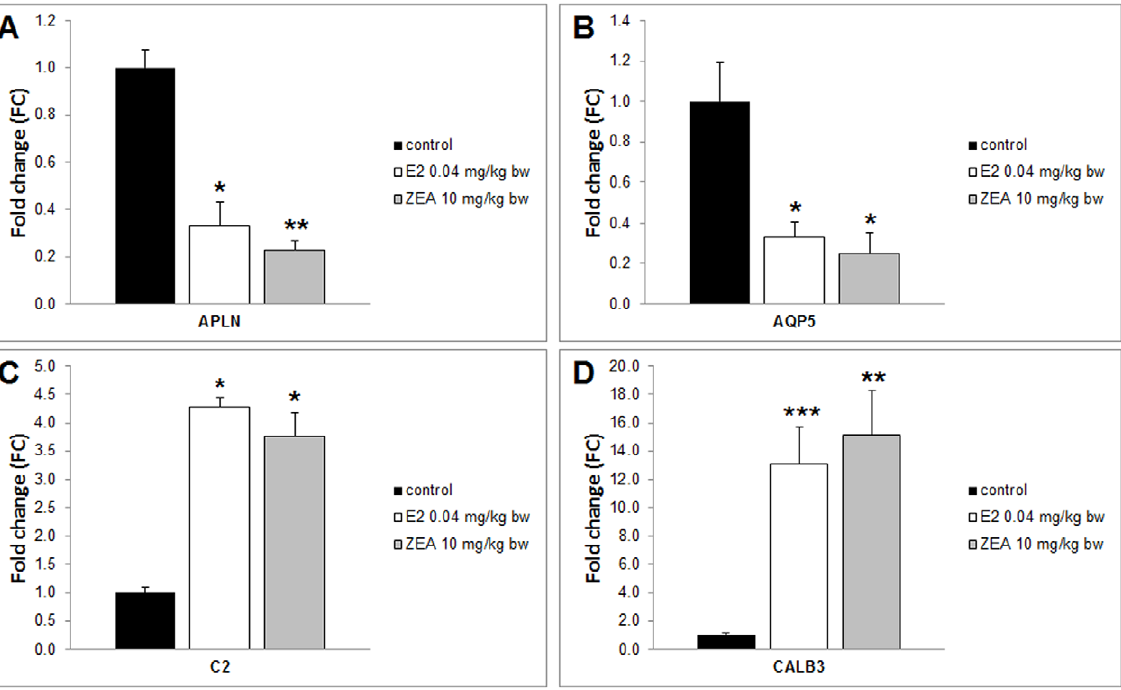
Figure 4. Gene expression of apelin, aquaporin 5, complement component 2 and calbindin 3 in Experiment1 . Gene expression of apelin (APLN) and aquaporin 5 (AQP5) decreased and complement component 2 (C2) and calbindin 3 (CALB3) increased significantly both by E2 0.04 mg/kg bw and ZEA 10 mg/kg bw 3-day-long treatment. (*) Significantly different from control (p , 0.05). (**) Significantly different from control (p , 0.01) (n=6–7). (***) Significantly different from control (p , 0.001) (n=6–7).